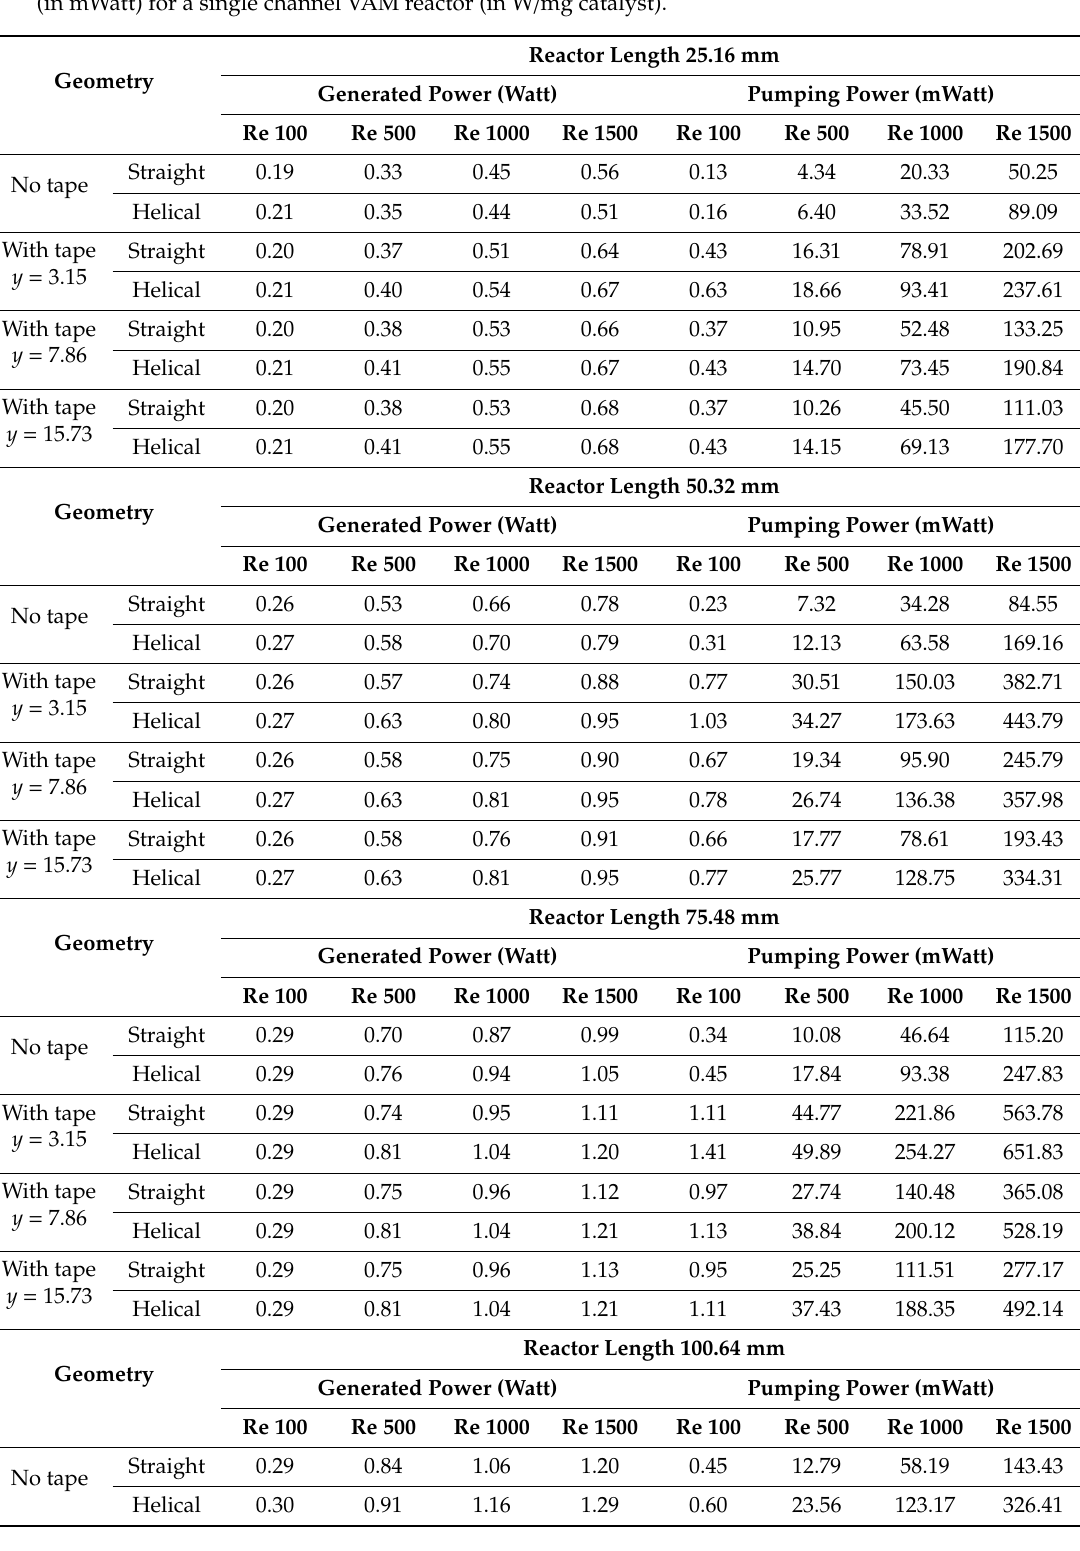
Table 1. Power generation from methane combustion (in Watt) and pumping power to drive the flow (in mWatt) for a single channel VAM reactor (in W / mg